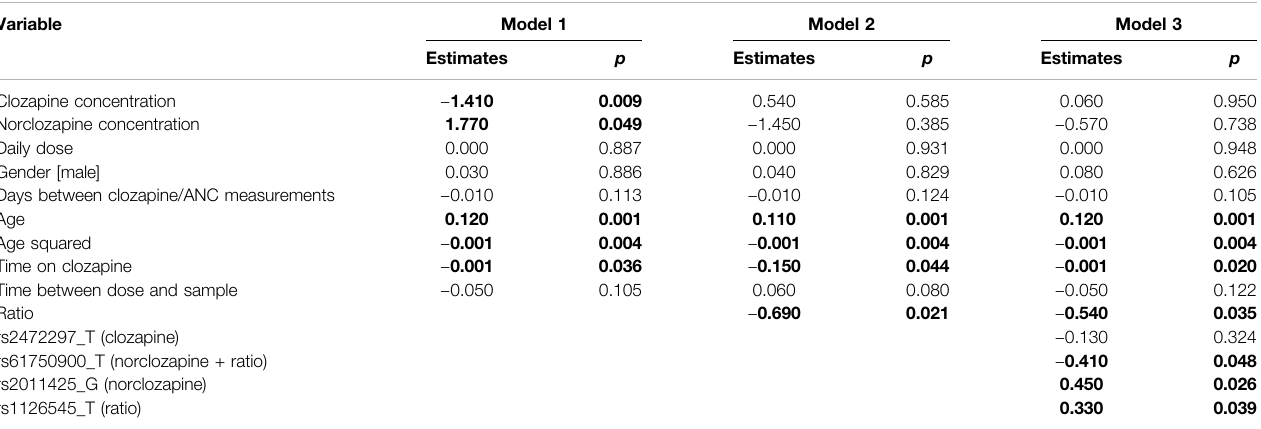
TABLE 4 | Results of the three regression analyses with ANC as outcome.